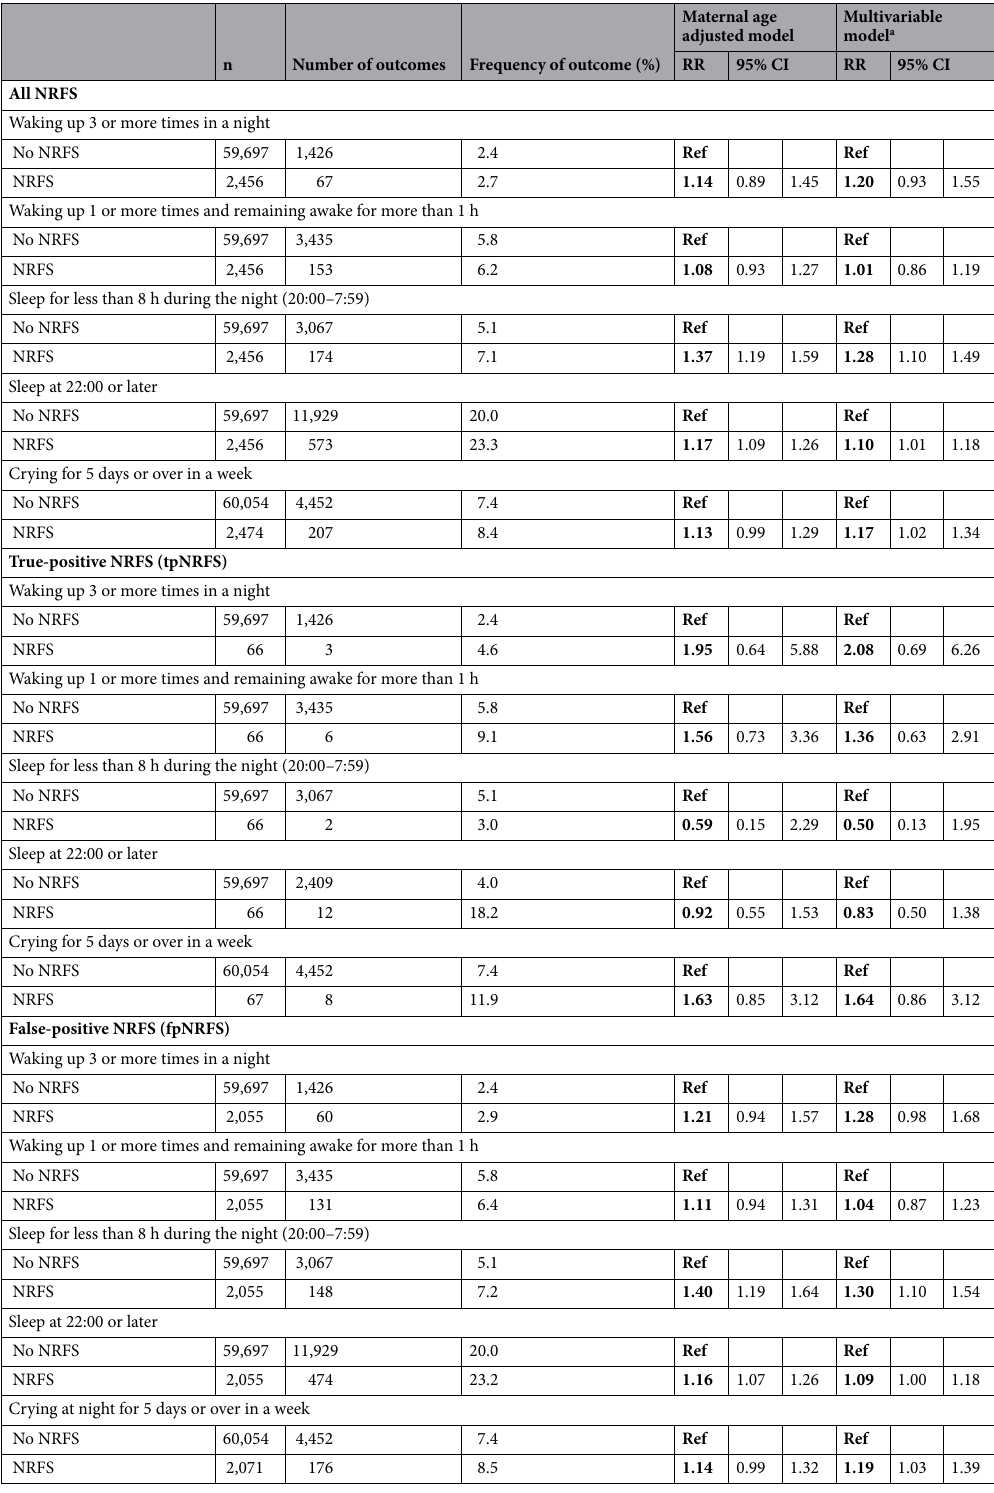
Table 2. Association between non-reassuring foetal status and infantile sleep at 1 year of age. CI confidence interval, RR risk ratio. a Adjusted for maternal age at delivery, smoking habits, alcohol consumption, pre- pregnancy body mass index, parity, infertility treatment, type of delivery, gestational age at birth, small for gestational age, infant sex, psychological distress at 1 year after delivery, doctor diagnosis of asthma and atopic dermatitis at 1 year old, and feeding